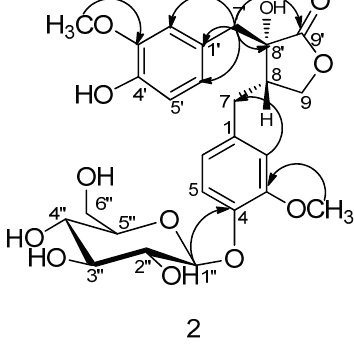
Figure 2. Key HMBC correlations of compounds 1 and 2